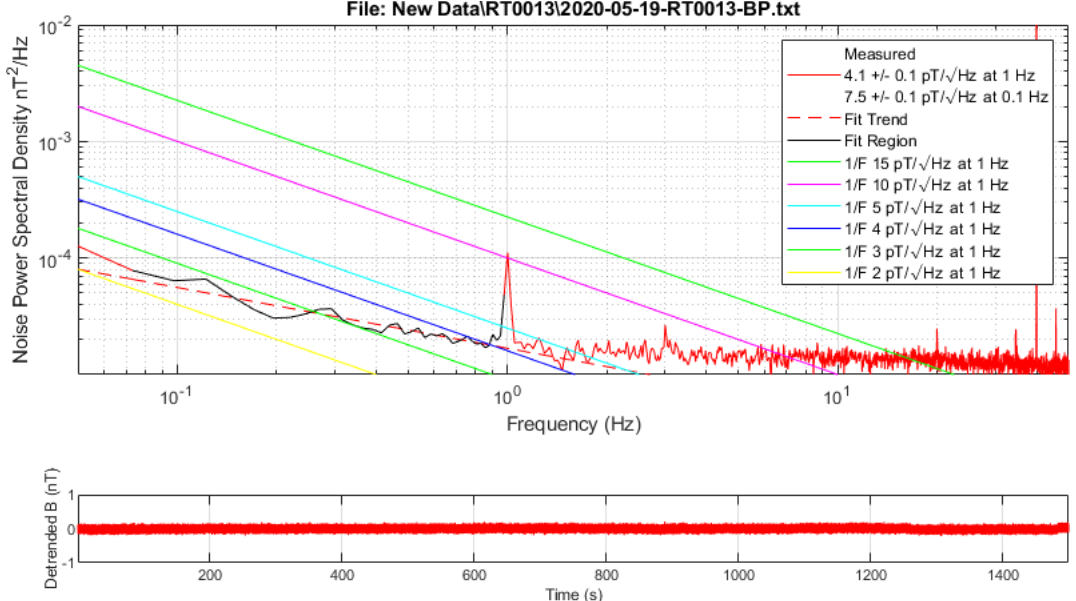
Figure 7. Example noise floor plot for core RT0013 (6-81, 50µm, 1150 ◦ C dwell). Note that the noise trend below ∼ 1Hz appears to be significantly below the expected 1/F. The narrow-band feature 1Hz is instrumental and related to 1sps packetization and transmission over a USB